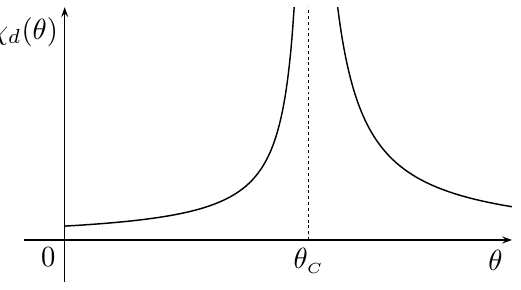
Figure 1. The (Landau) differential magnetic susceptibility χ